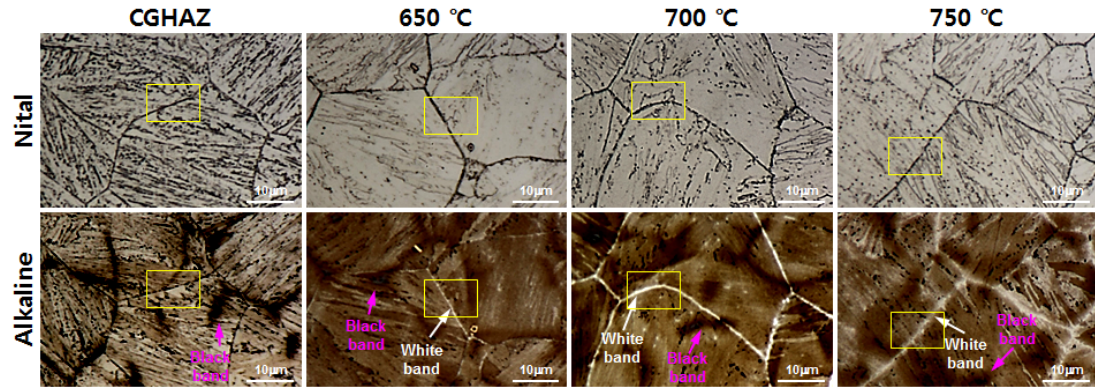
Figure 4. Optical microstructure with etchants (nital, alkaline sodium picrate) at various PWHT temperatures. (The yellow rectangle is the position observed by SEM in Figure 5).